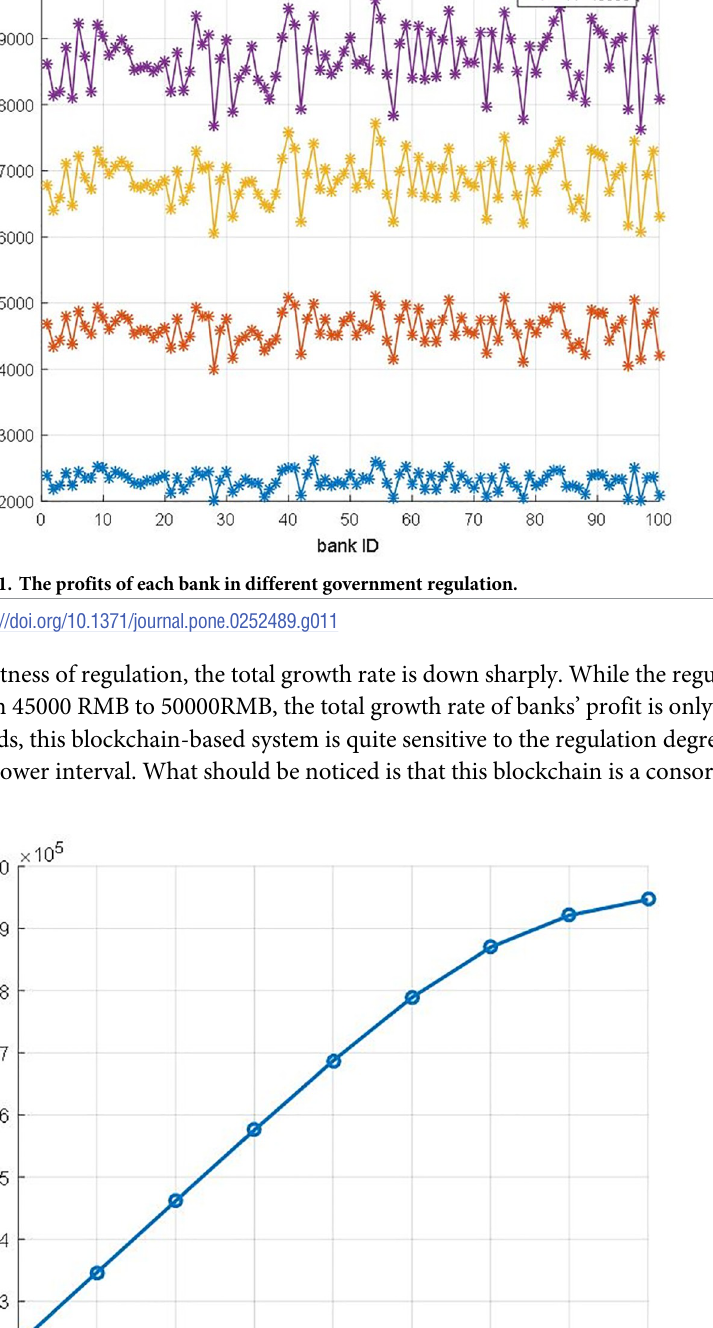
Fig 12. The profits of the whole bank